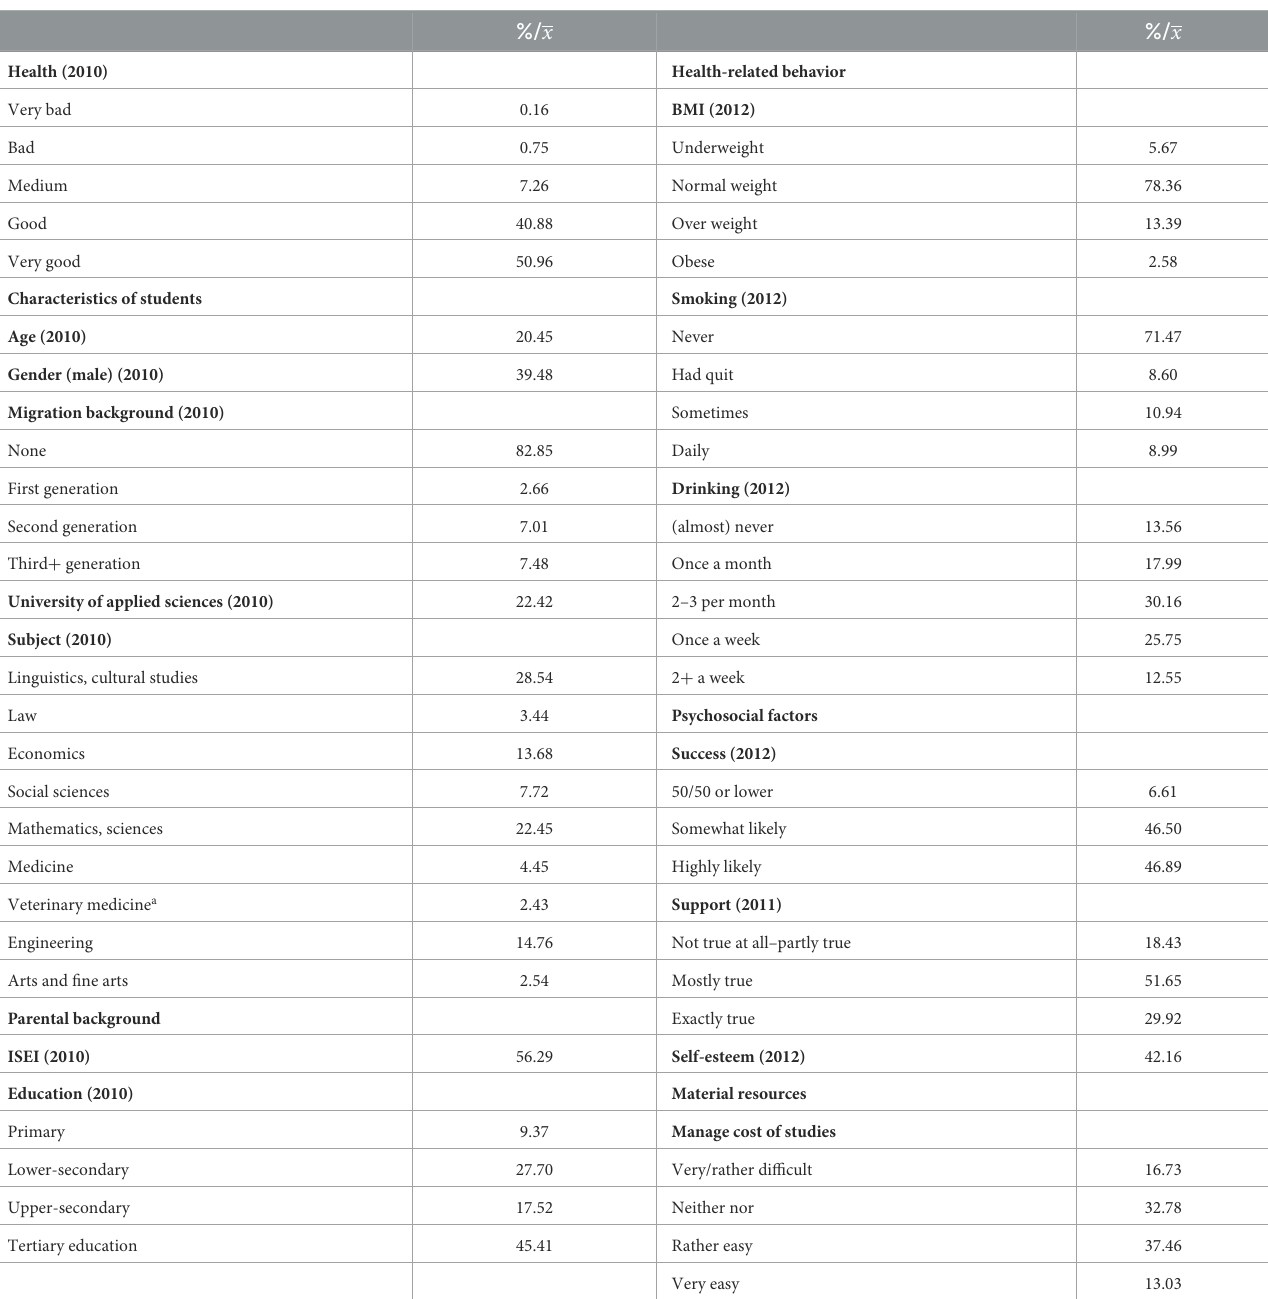
TABLE 2 Descriptive statistics for initial characteristics of students in 2010, 2011, and